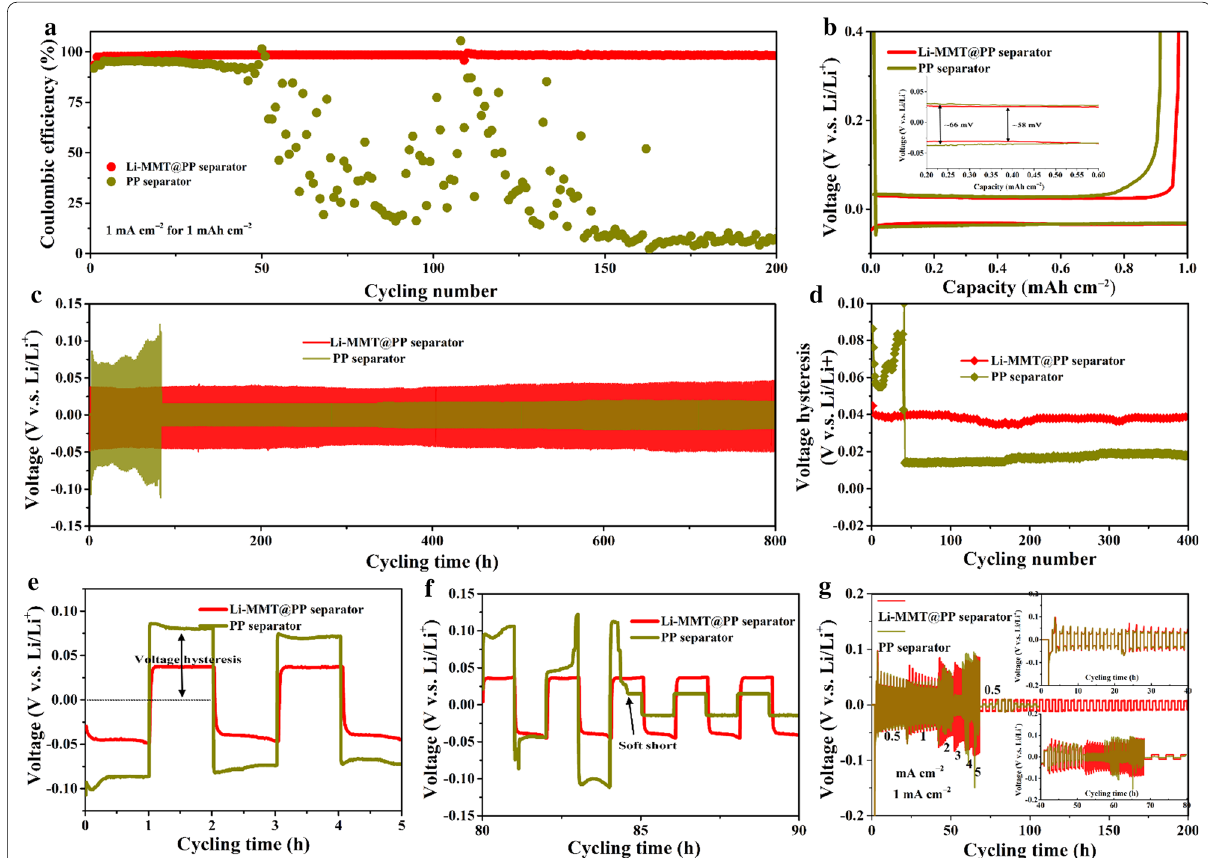
Fig. 2 Electrochemical performances of Li||Cu and Li||Li symmetric batteries. a CE curves and b corresponding voltage curves. c Voltage–time profiles of the Li||Li symmetric batteries using Li-MMT@PP or PP separator at 1 mA cm − 2 with a capacity of 1 mAh cm − 2 . d Voltage hysteresis of Li||Li symmetric batteries. e , f The partial enlargement profiles of c . g The rate performances of Li||Li symmetric